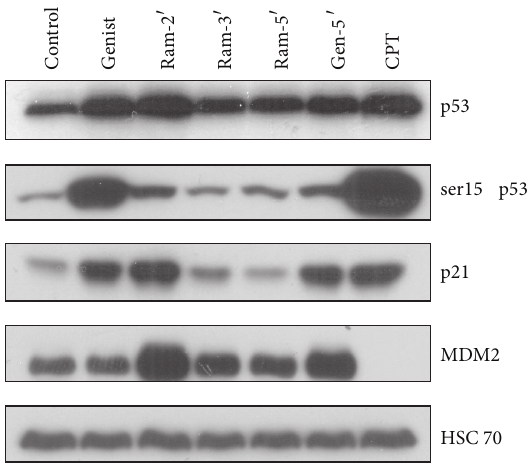
Figure 8: The level of total p53, phosphorylated p53 (ser 15), p21 and MDM2 in HCT 116wt cells treated for 24 h with the tested genistein derivatives used at the concentration equivalent to 3x IC 50 (Ram-2 󸀠 (3 𝜇 M),Ram-3 󸀠 (40 𝜇 M),Ram-5 󸀠 (20 𝜇 M),Gen-5 󸀠 (20 𝜇 M). Genistein (Genist) and camptothecin (CPT) were used as positive controls. HSC 70 served as a loading control.